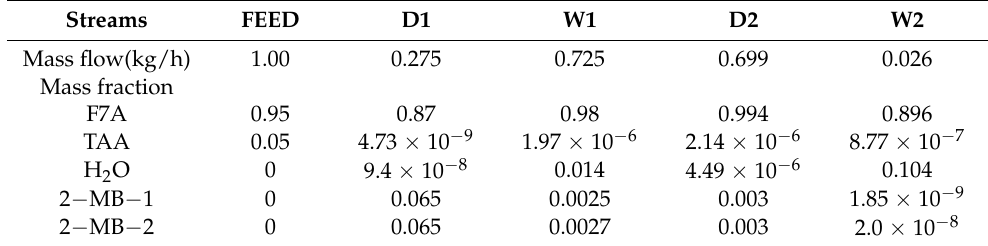
Table 4. Key parameters and heat duty in column 1 and column 2. Parameters Column 1 Column 2 Number of